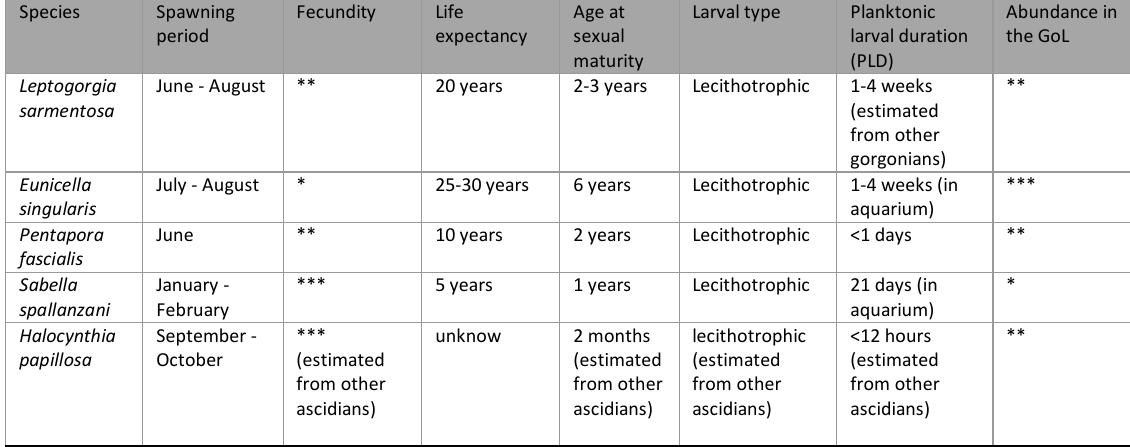
Table 1: Supplementary Material). Second, the effect of factors age (2 levels: 1985 and the 2000s) and depth (2 levels, >20 m, <20 m depth) was tested within the AGD geographical sector only. Factor age was tested in 3 sites at <20 m (AGD1/ AGD2 & AGD3) and factor depth was tested in 4 sites deployed in 2009 (AGD2&AGD3 / AGD4&AGD5). Third, factor location was tested both at regional and local levels (geographical sector being the regional factor, site being the local factor). To avoid any confounding effect due to age or depth, the regional factor vs the local factor were tested on the 5 geographical sectors where AR were deployed during the 2000s immersion phase and at <20 m depth only (AGM, AGD, VLR, GRU, LEU: 5x2